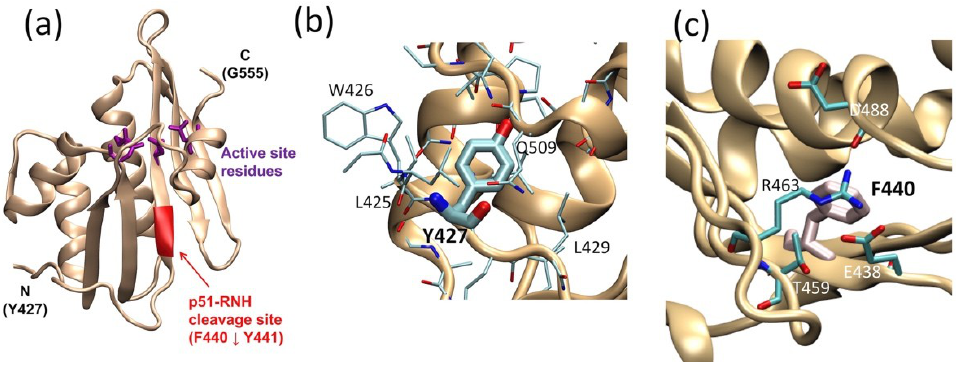
Figure 2. RNH domain structure, highlighting ( a ) the p51-RNH processing site (i.e., F440–Y441, red ribbon) and the active site (purple sticks), ( b ) the Y427 side chain (thick stick), and ( c ) F440 cleavage site. In panels ( b , c ) the side chains of the surrounding residues are shown. The graphic presentation was made using VMD software [65] and the RT structures (PDB 3KK2 [72] or 1DLO [66]).